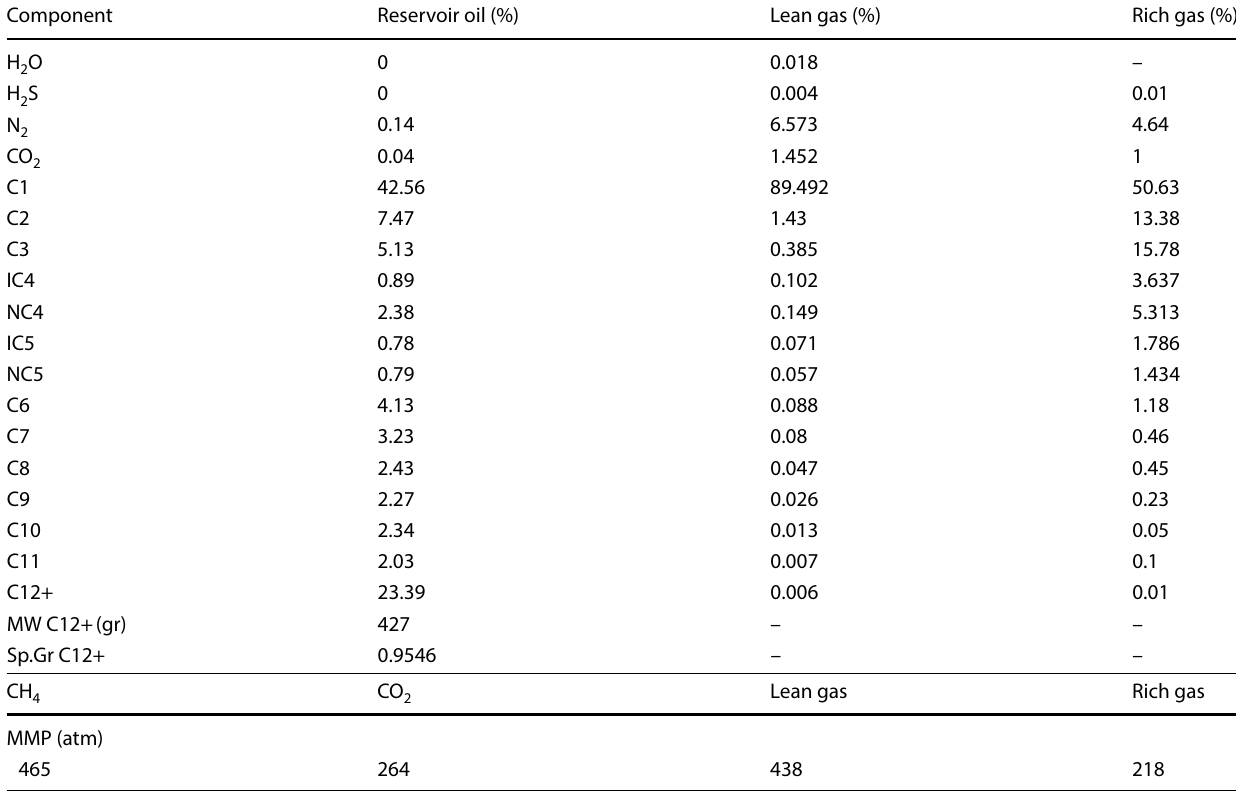
Table 1 Composition of reservoir oil, lean gas and rich gas and obtained MMP of different gases Component